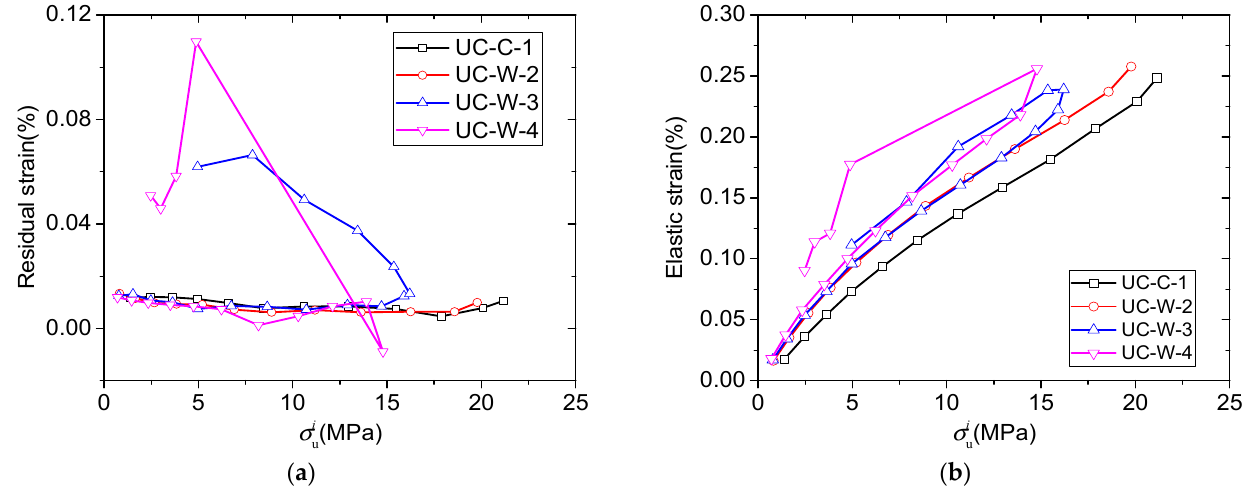
Figure 13. ( a ) Relationship between unloading stress and residual strain, and the ( b ) relationship between unloading stress and elastic strain.